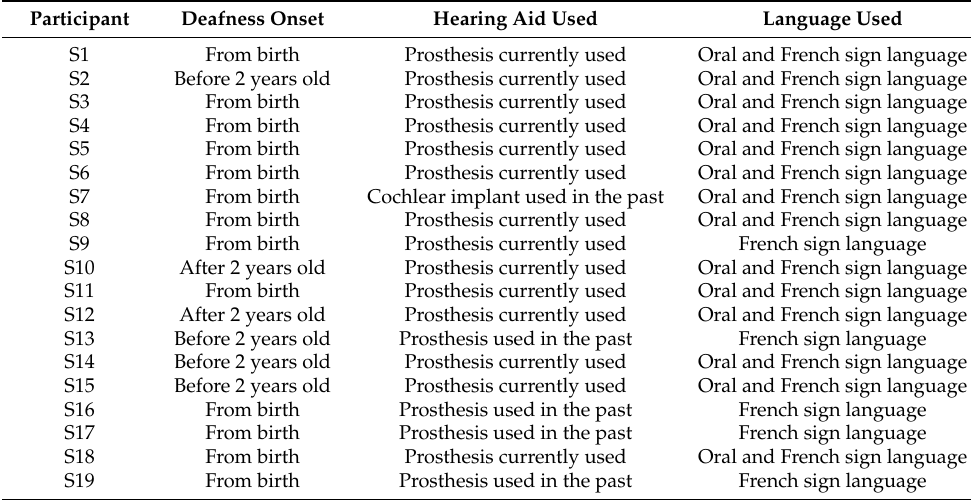
Table 1. Demographic information about deaf